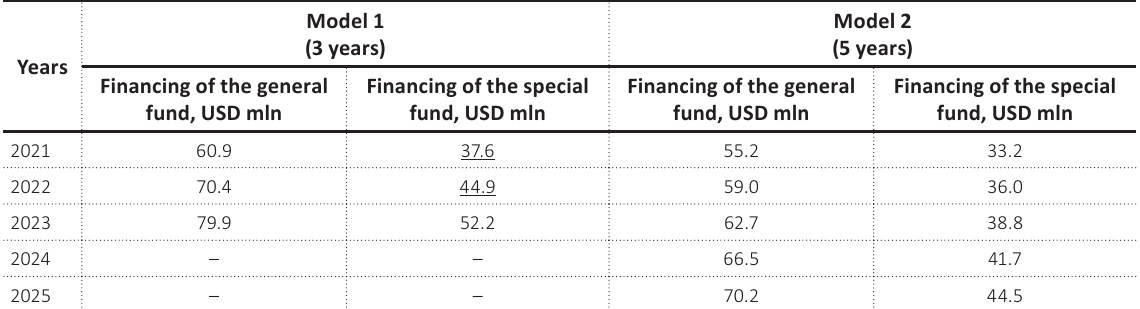
Table 3. Estimated financing for the University during